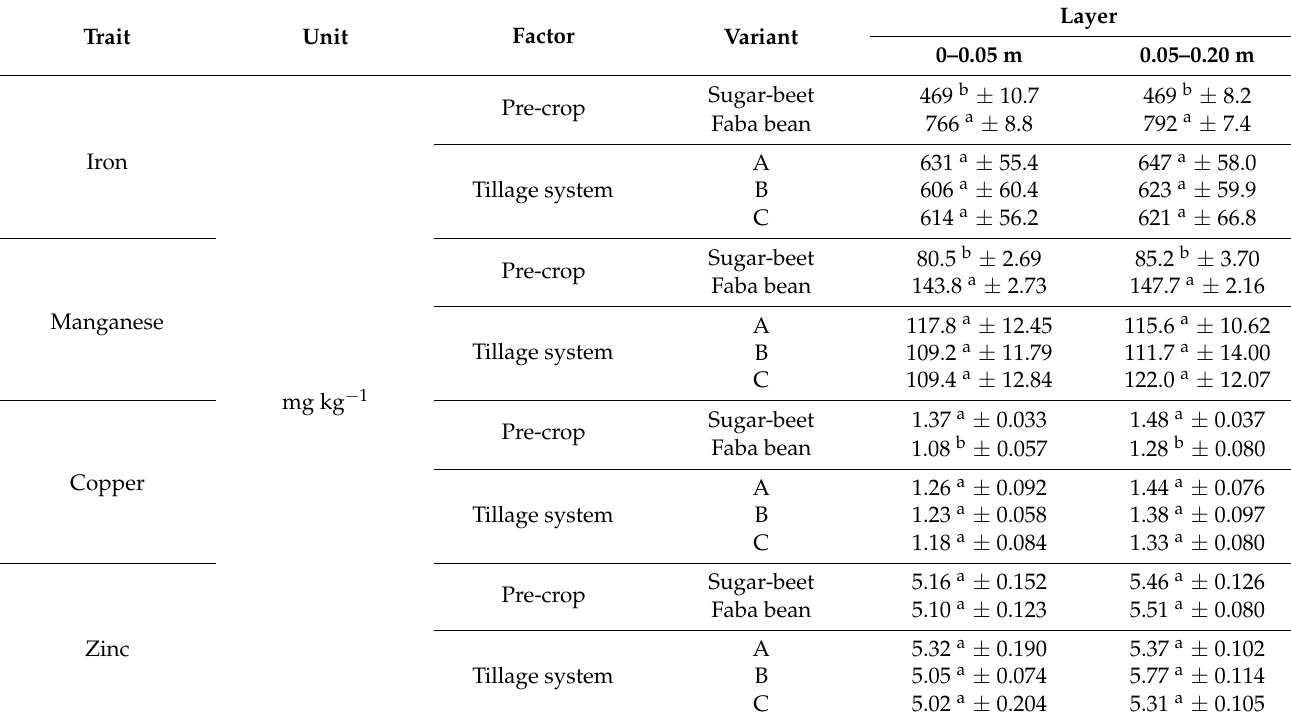
Table 4. Micronutrients contents in soil depending on pre-crop and tillage